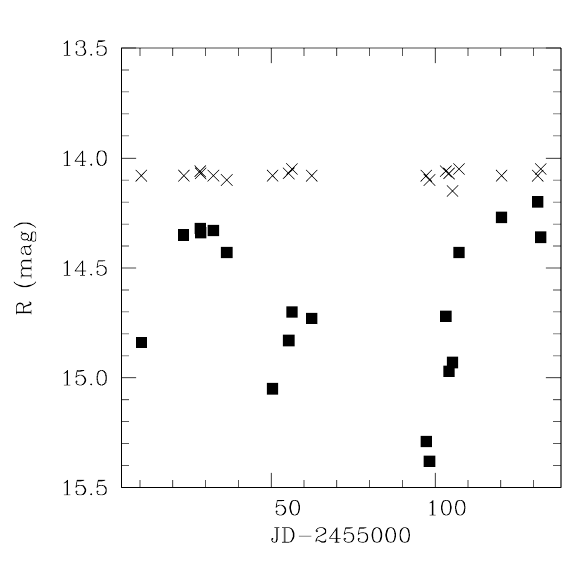
Fig. 2. The light curve of V2282 Sgr in the summer of 2009 from CCD images. Filled squares are for the variable, crosses are for a comparison star with F = 14 . 07 mag. most likely physical